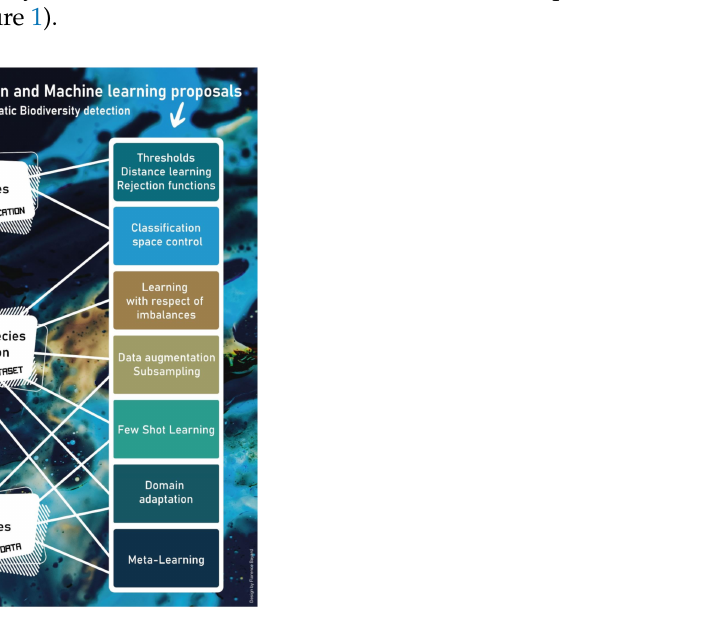
Figure 1. Ecological rules, their impacts on machine learning and state-of-the-art proposal to answer